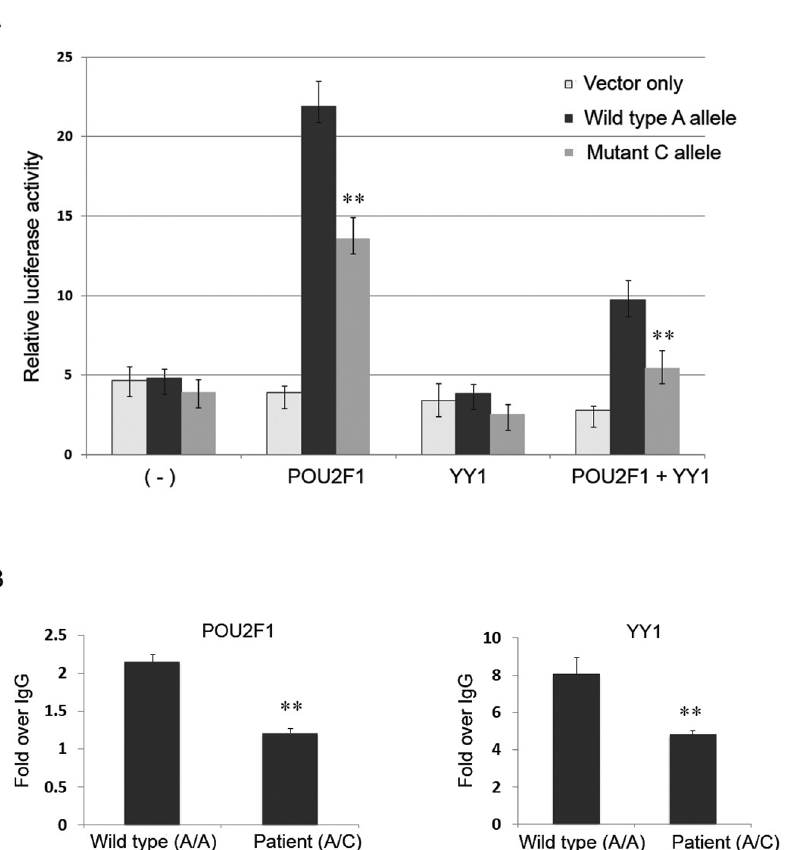
Figure 4. The 4q32A . C mutation leads to reduced enhancer activity and POU2F1 and YY1 binding. (A) Luciferase assays of the enhancer activity using the thyroid cancer cell line BCPAP. **, p-value , 0.005. (B) ChIP assay for transcription factors POU2F1 and YY1 using antibodies against POU2F1 and YY1 in lymphoblastoid cell lines. The control and patient cell lines are the same as in Figure 2. **, p-value , 0.01. Error bars represent 6 SD of at least three independent experiments.